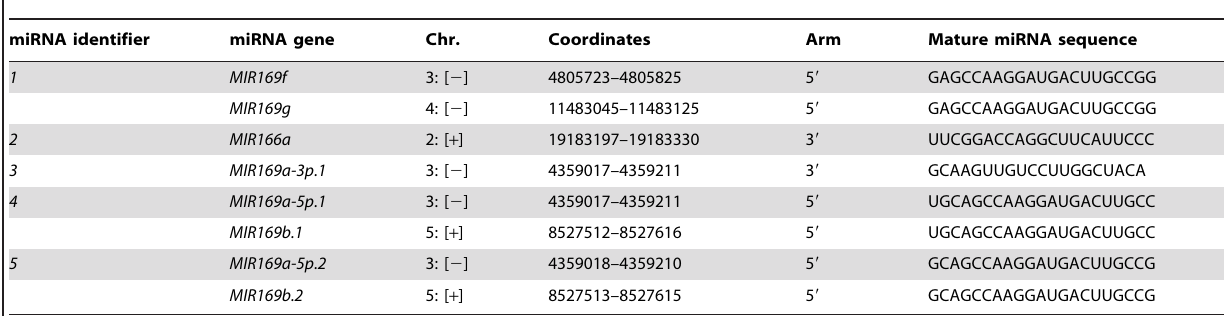
Table 2. Newly identified mature miRNAs in Arabidopsis